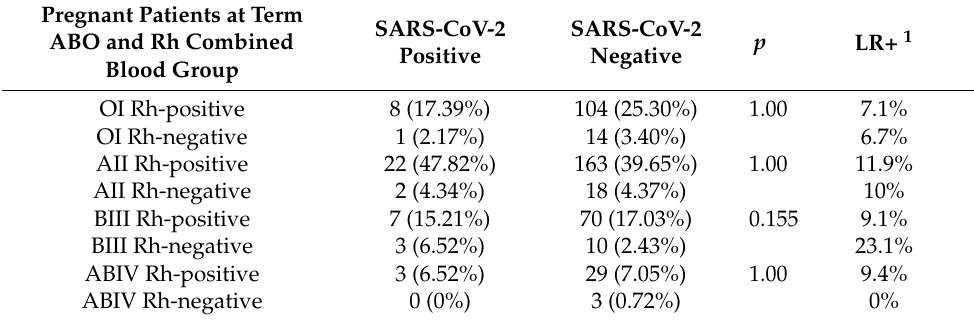
Table 4. Number and percentage of ABO and Rh combined blood groups in the SARS-CoV-2 positive and SARS-CoV-2 negative pregnant patients at term, and significance p , according to the Fisher exact test.